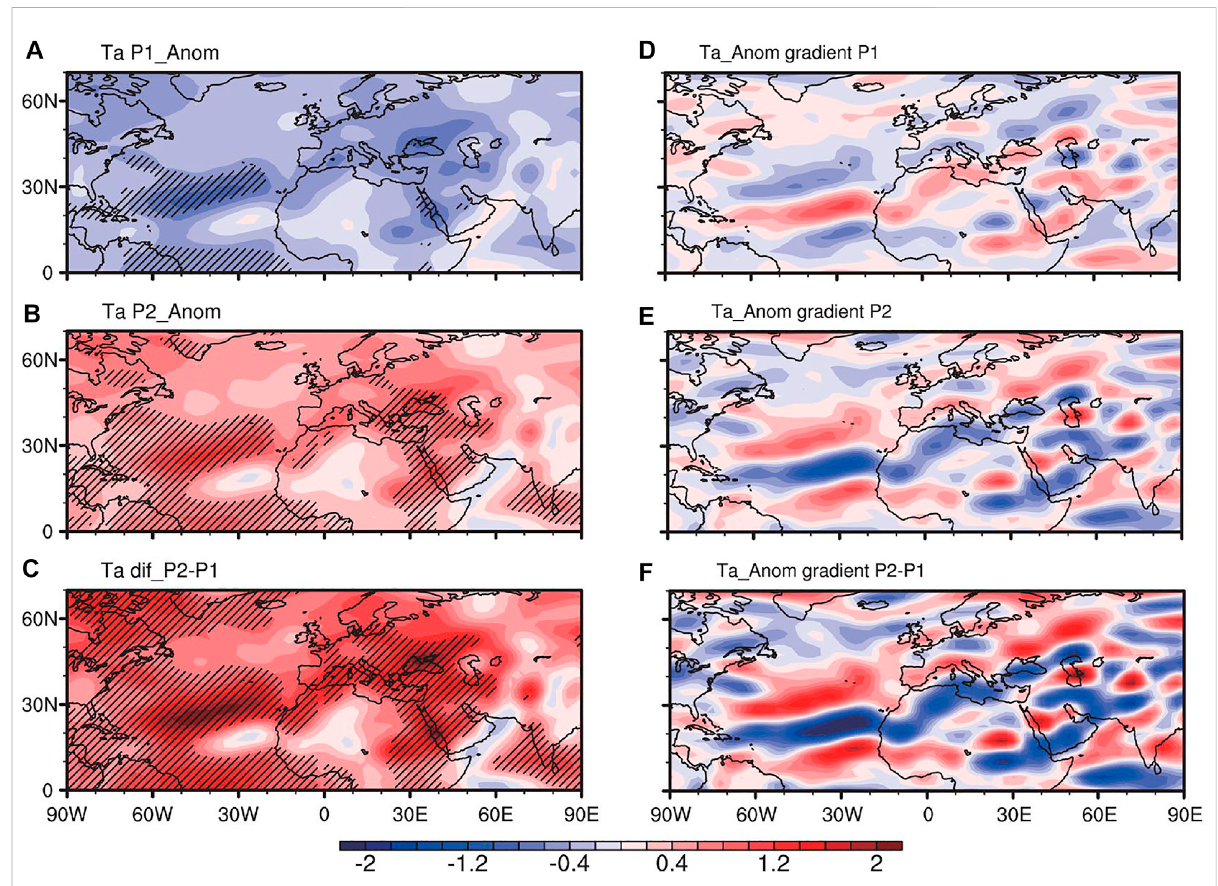
FIGURE 6 Differences in terms of the 850 hPa air temperature between (A) P1 and the climatology, (B) P2 and the climatology, and (C) P2 and P1 (unit: K). Dashed areas indicate signi fi cance at 99% con fi dence level according to the Student ’ s t -test. [ (D – F) ] The meridional gradient of air temperature in [ (A – C) ], respectively (unit: K kkm − 1